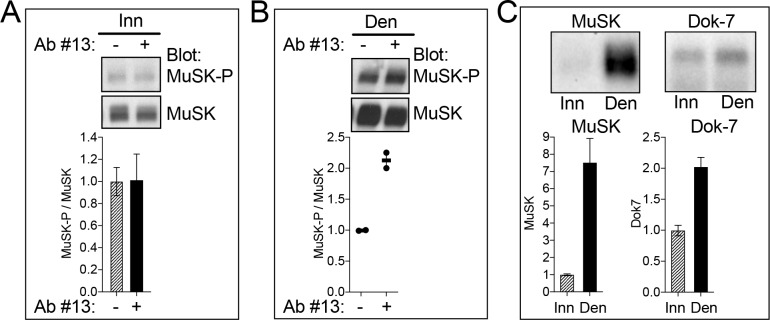
MuSK agonist antibody #13 stimulates MuSK tyrosine phosphorylation in vivo.(A) The MuSK agonist antibody (Ab #13) failed to stimulate MuSK phosphorylation in innervated (Inn) muscle, suggesting that MuSK may be maximally phosphorylated at synapses by Agrin and Lrp4. (B) Following denervation (Den), non-synaptic regions of muscle express MuSK, but not neural Agrin. Ab #13 stimulated MuSK phosphorylation in denervated muscle by 2.2-fold, demonstrating that Ab #13 activates MuSK in vivo. (C) Following denervation, MuSK expression increases 7.5-fold, but expression of Dok-7, an essential, inside-out activator of MuSK, increases only 2.0-fold. Thus, the activity of Ab #13 in denervated muscle may be limited by low non-synaptic Dok-7 expression. (A, B) The ratio of MuSK-P/MuSK in the absence of Ab #13 was assigned a value of 1.0. (C) The level of MuSK and Dok-7 expression in innervated muscle was assigned a value of 1.0. The SEMs (n = 3) are shown in (A, C); values and averages from two experiments are shown in (B).